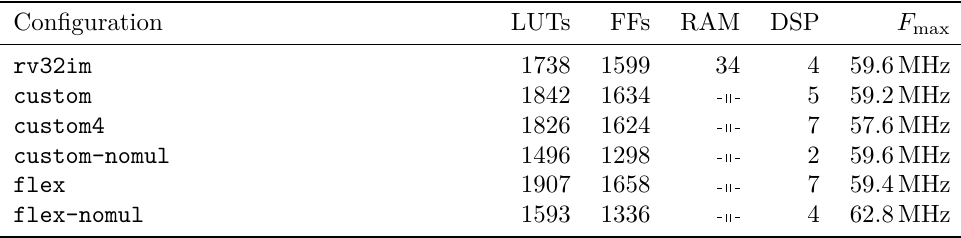
Table 6: Xilinx Artix-35T device utilization and speed for varying